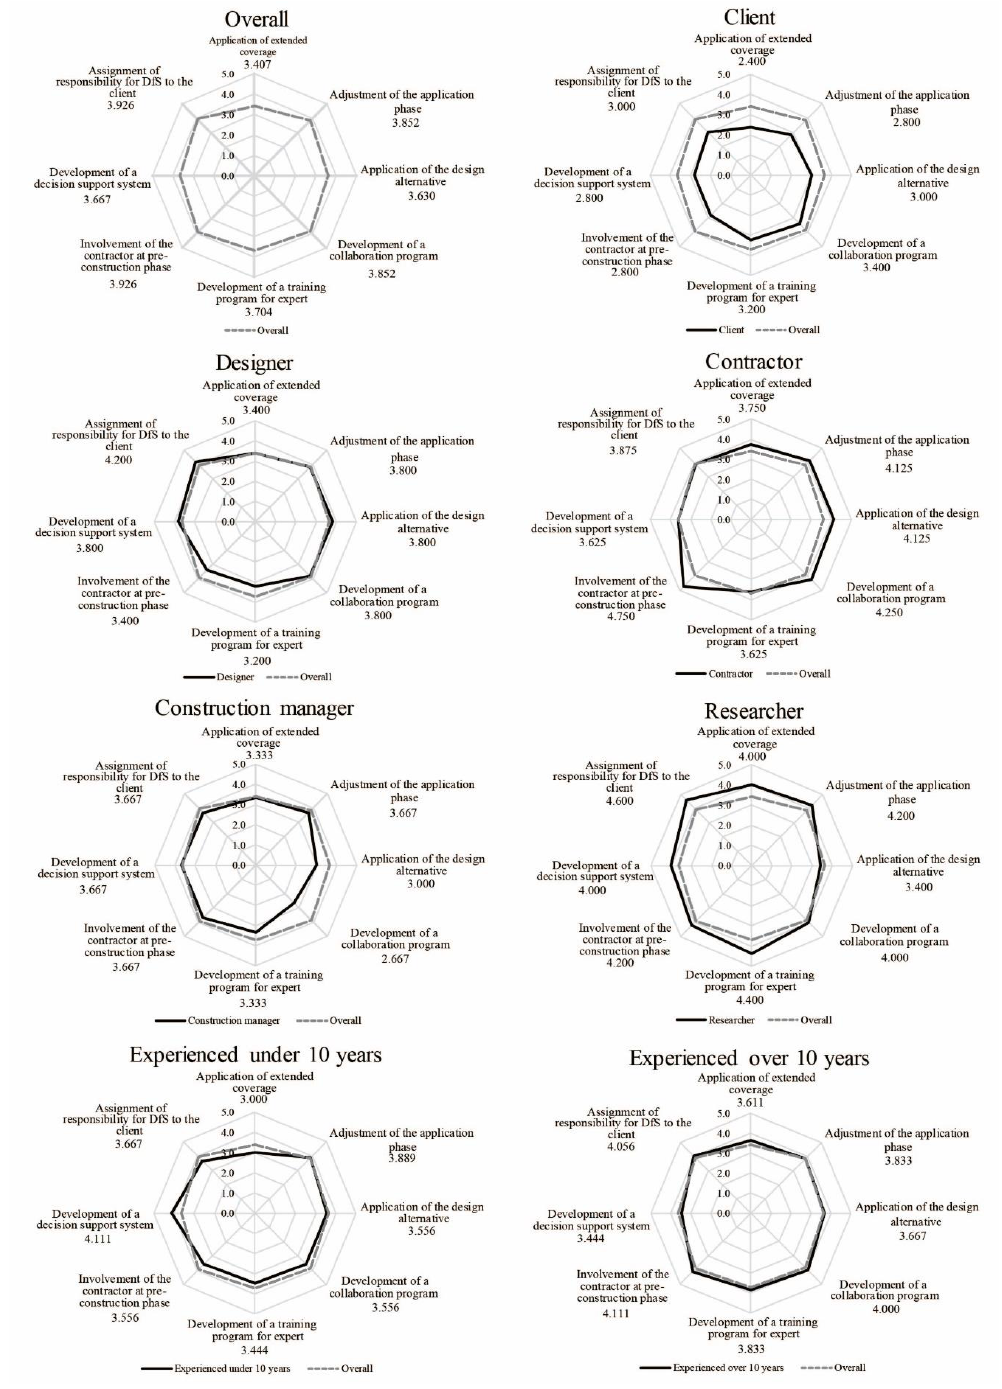
Figure 3. Result of absolute importance of DfS alternatives.